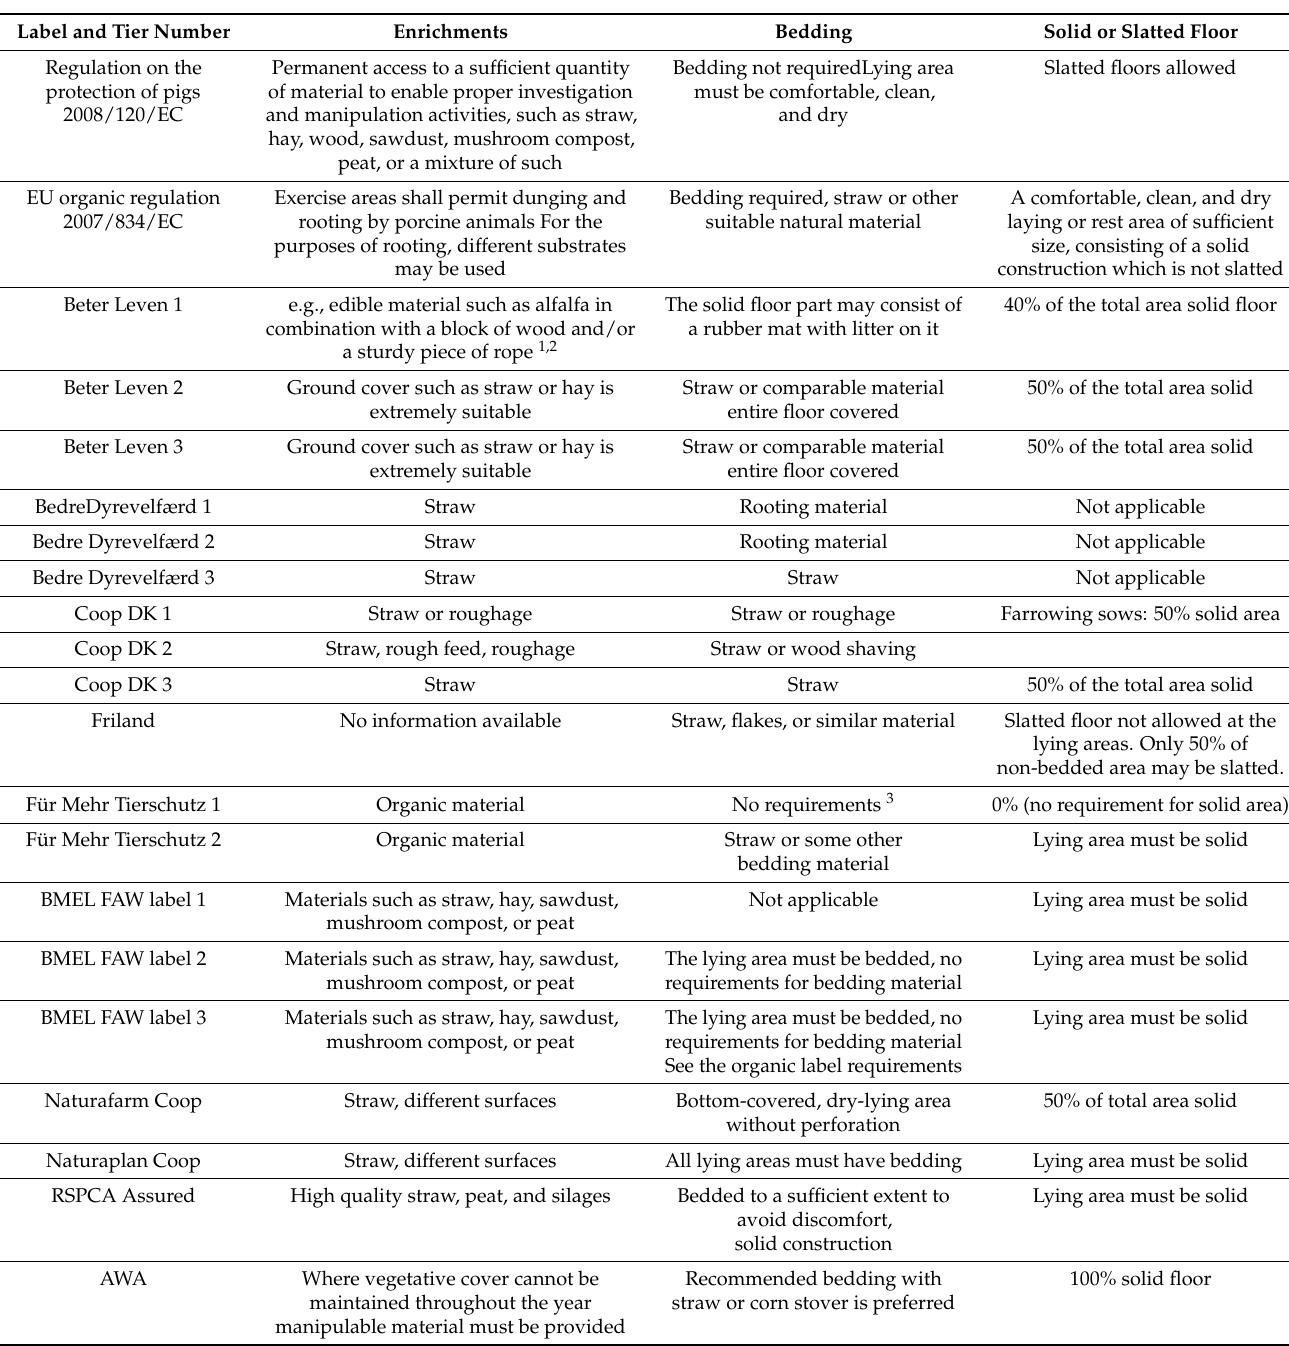
Table 2. Enrichments, bedding, and floor type definitions in the animal welfare labeling schemes studied, the EU regulation on the protection of pigs (2008/120/EC), and in organic regulation